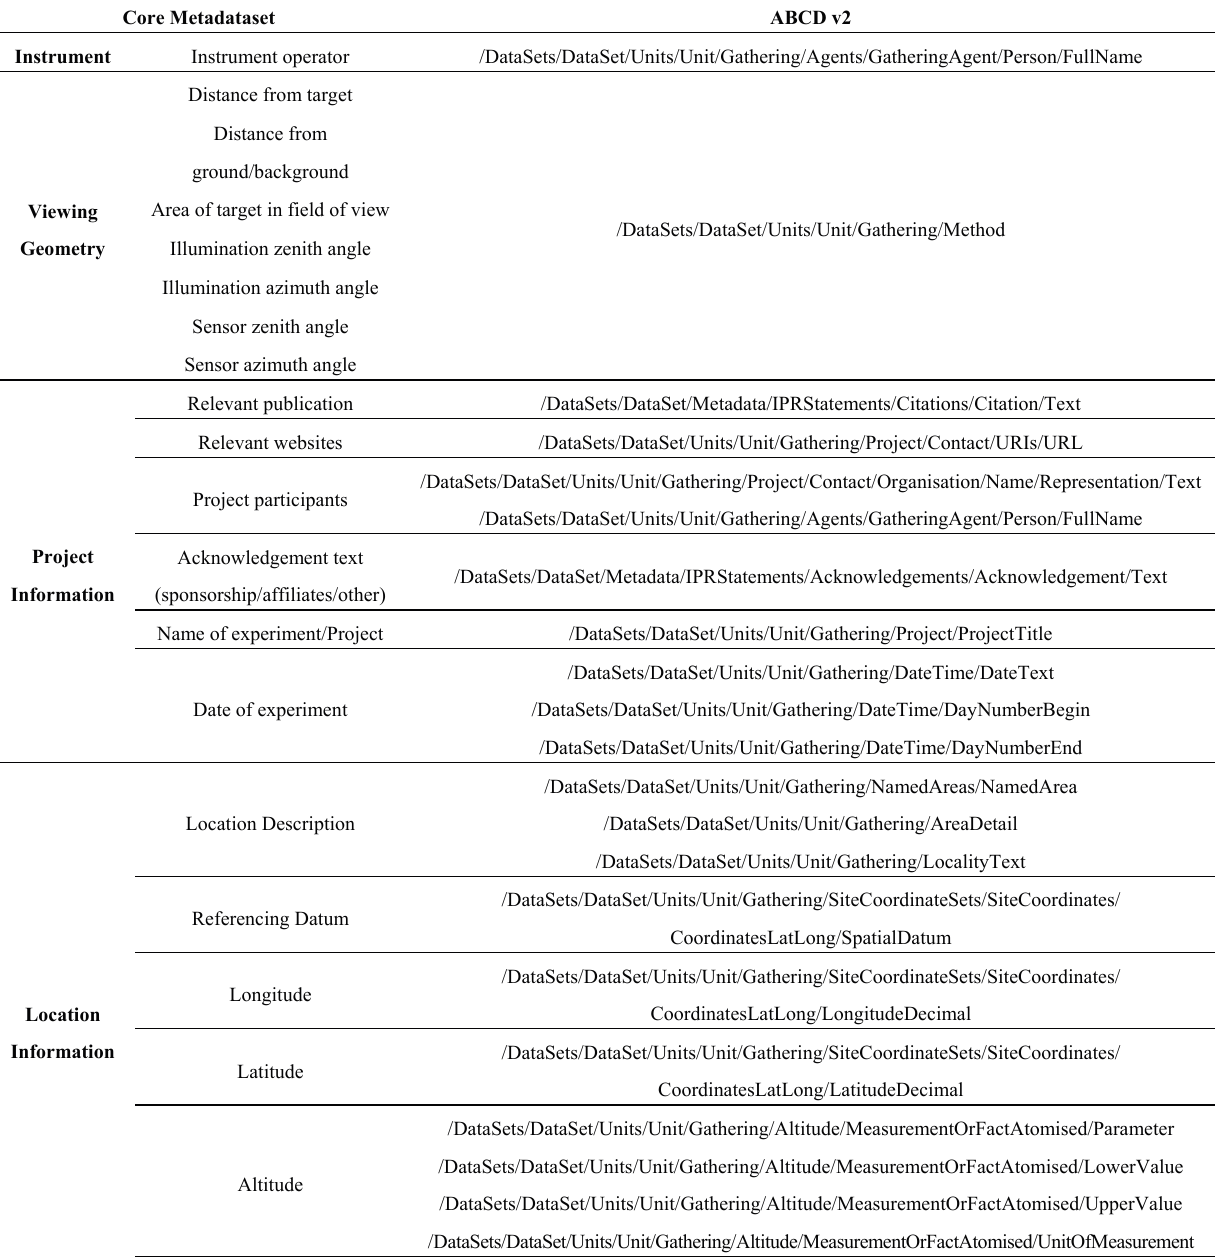
Table A1. Mappings from Access to Biological Collections Data Schema 2.06 to the Core